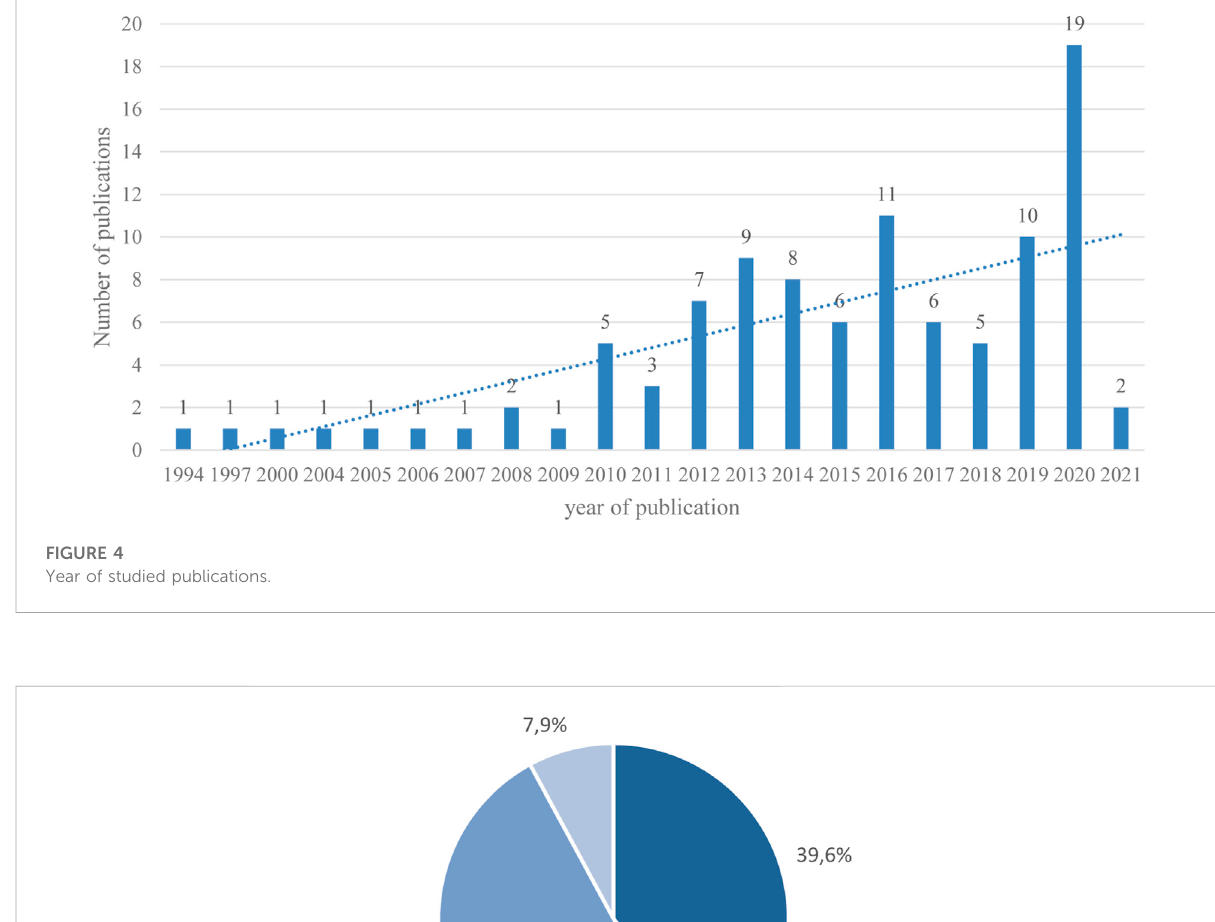
FIGURE 5 Type of company of studied